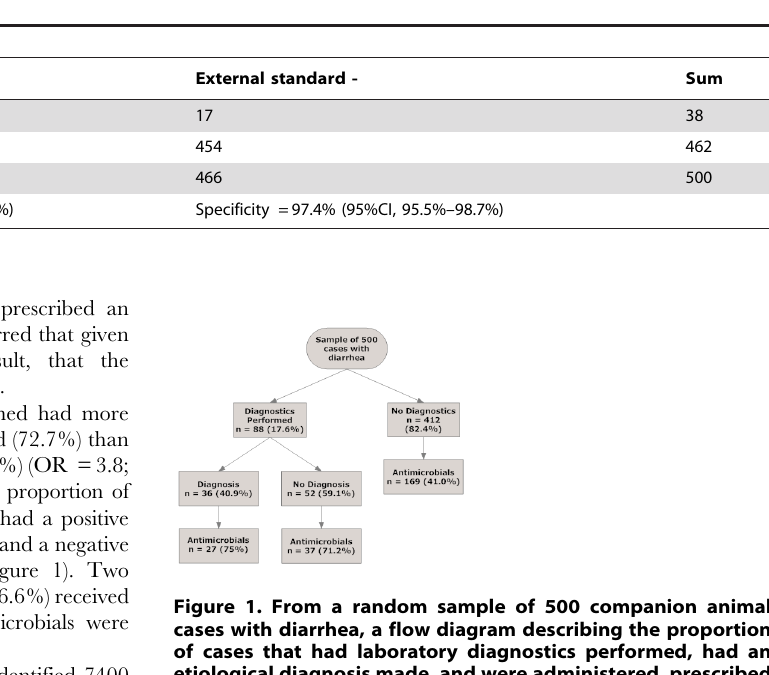
Table 2. From a random sample of 500 companion animal cases of diarrhea, the accuracy of the text miner for classifying the cases as positive or negative for ‘ had an etiological diagnosis made ’ when compared to a manual review of the medical records serving as the external standard.